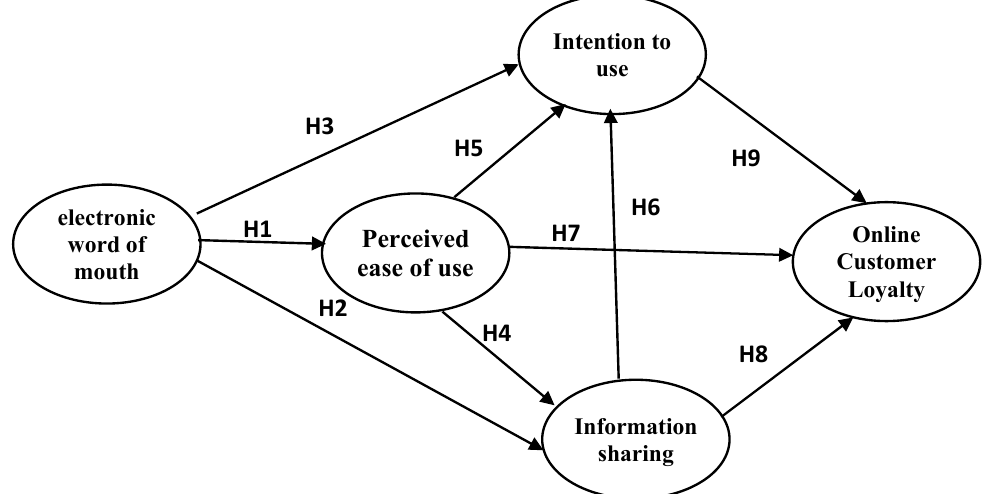
Fig. 1. Research Concept